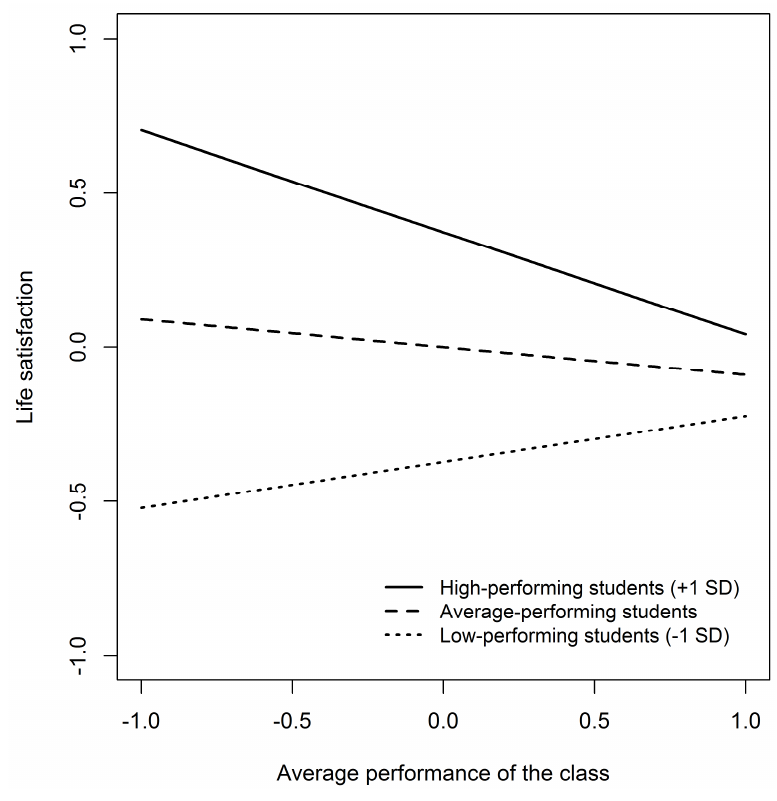
Figure 1. Predicted differences in school-aged children’s life satisfaction depending on individual performance and class-level average performance. Legend: Slopes from Model 4 for students at average performance and those students one standard deviation (SD) above as well as one standard deviation below students’ average performance. Higher values for the class-level average performance indicate higher-performing classes and vice versa. Life satisfaction is on a 0–10 metric and the figure shows differences in life satisfaction. The mean performance on the metric scale of 1 (“unsatisfactory”) to 6 (“very good”) was 4.32 (SD = 0.79). The figure was created with R [66].